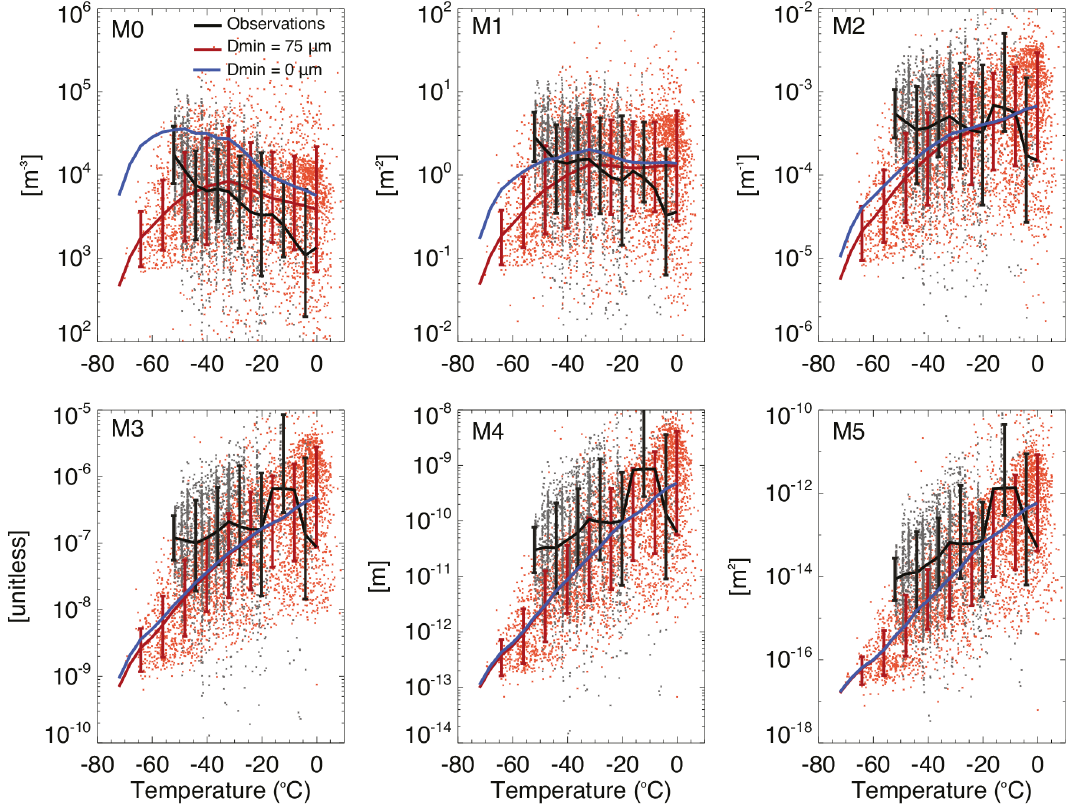
Figure 4. Moments from ARM-IOP (black: measurements. red: model integrated from 75µm, blue: model integrated from 0µm). Lines are geometric mean, dots represents a fraction of the measurements and model results, while vertical lines are the geometric standard